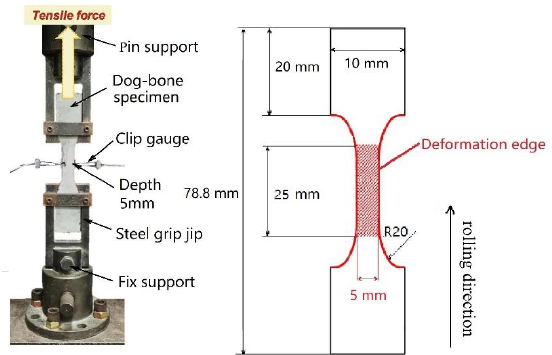
Figure 3. Test setup and the details of the tensile specimens of the dog bone geometry.